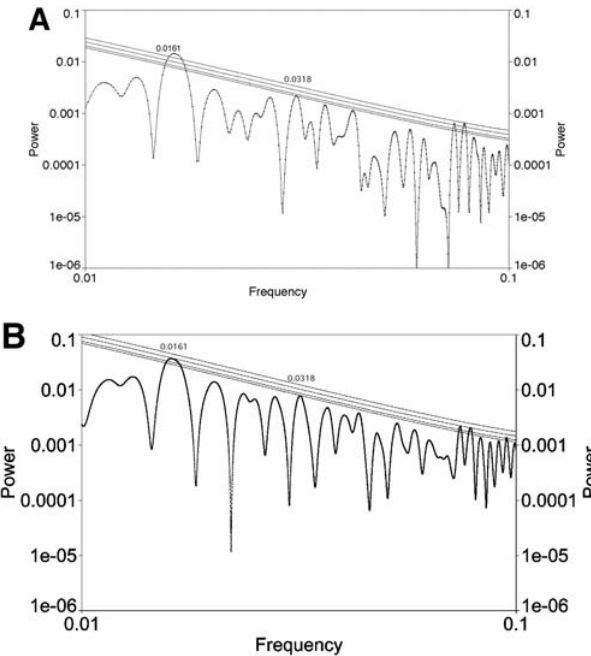
Figure 2. Analysis of fractional fossil biodiversity fluctuations with LS; analysis used AutoSignal and significance levels were computed assuming Gaussian fluctuations. Lines denote 0.1, 0.05, 0.01, and 0.001 levels of significance. Frequencies are given per Myr. A. Analysis of data detrended using the cubic. There is a peak at a frequency of approximately 0.0161/Myr which is equivalent to 62.1 6 3.1 Myr; this peak is significant at better than the .001 level. There is also a peak at a frequency of approximately 0.0318/Myr which is equivalent to 31.4 6 0.9 Myr, although this peak is only significant at the .1 level. All other significant peaks occur at less than 15 Myr and thus are near or below the Nyquist frequency. B. Analysis of data divided by actual diversity in each interval. There is a peak at a frequency of approximately 0.0161/Myr which is equivalent to 62.1 6 3.3 Myr; this peak is significant at better than the .01 level. There is also a peak at a frequency of approximately 0.0318/Myr which is equivalent to 31.4 6 0.9 Myr, although this peak is not significant at the .1 level. All other significant peaks occur at less than 15 Myr and thus are near or below the Nyquist frequency.